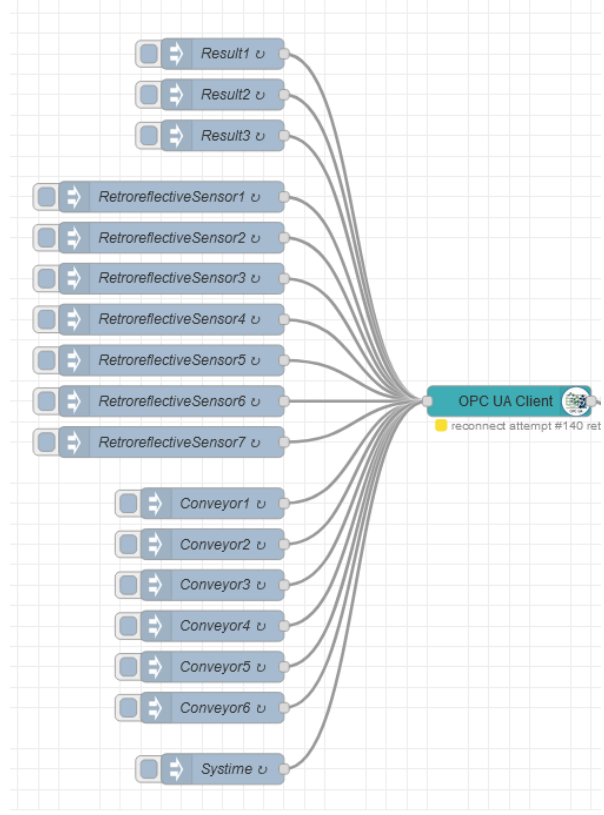
Figure 21. Local Node-RED—OPC UA